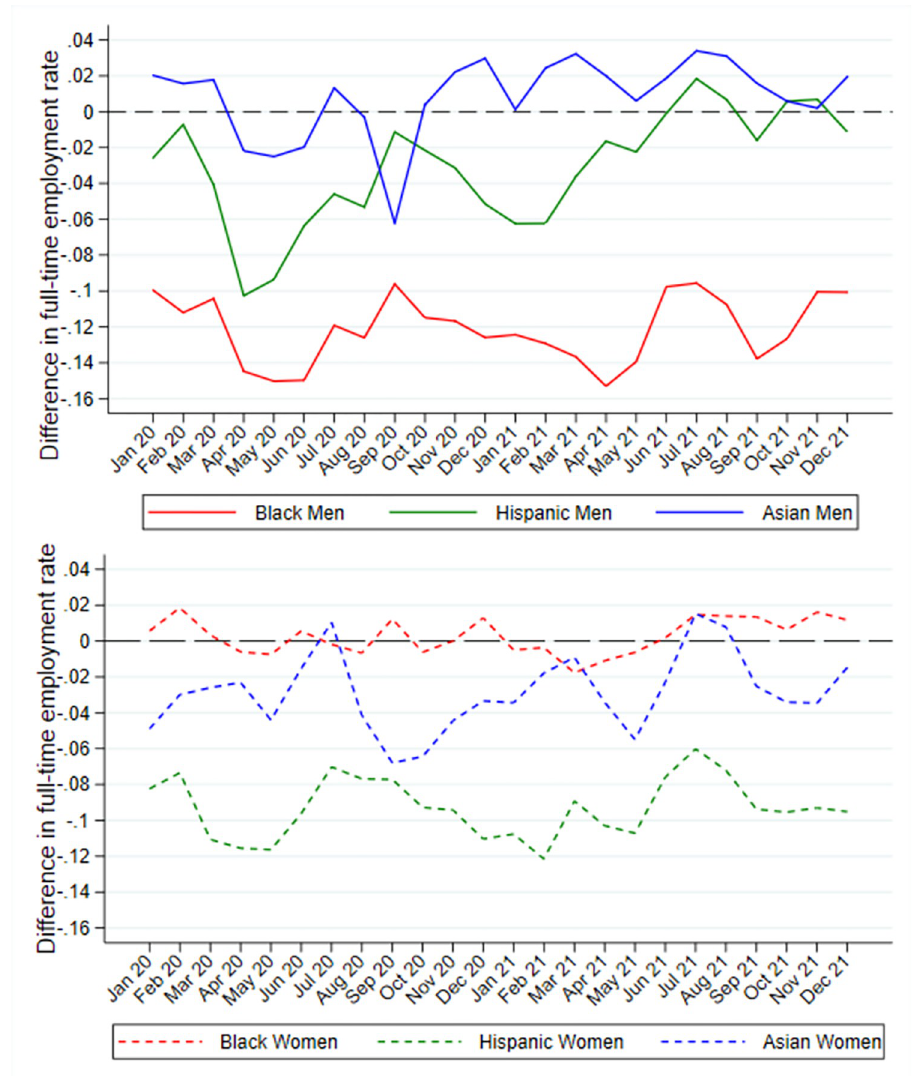
Fig 2. Difference in full-time employment rate for minority men and women relative to Whites, January 2020-December